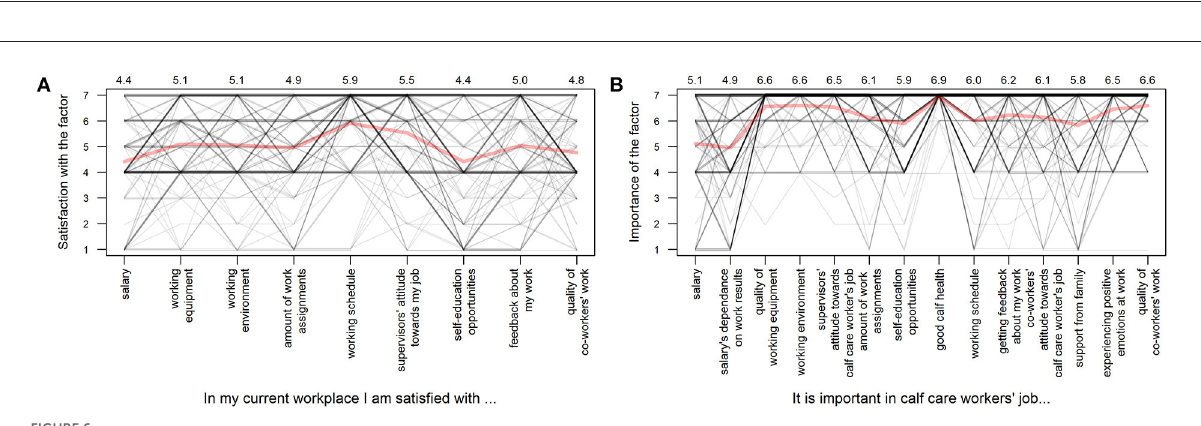
FIGURE6 The average scores on a 7-point Likert scale (1—not satisfied/important at all, 7—very satisfied/important) for statements regarding the calf care workers’ satisfaction with (A) and the importance of (B) different work-related factors ( n = 161 responses). The gray lines denote the individual answers and the red line represents the average score which is also shown numerically on top of the